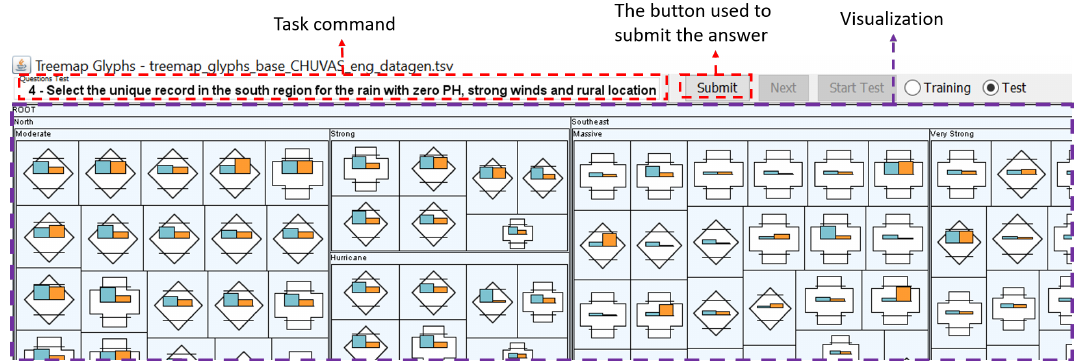
Figure 11. Example of task displayed to the participant, the task command and the submit button is above the